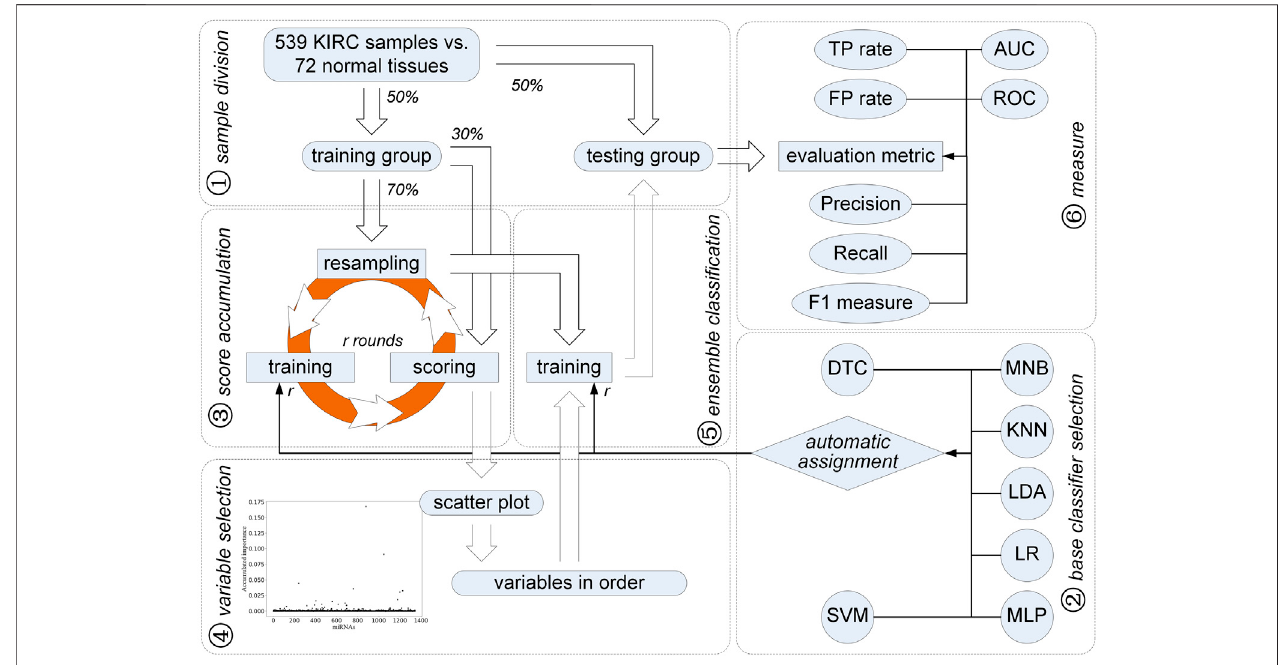
FIGURE 1 | Improved feature selection strategy for identi fi cation of miRNAs for diagnosis of KIRC.